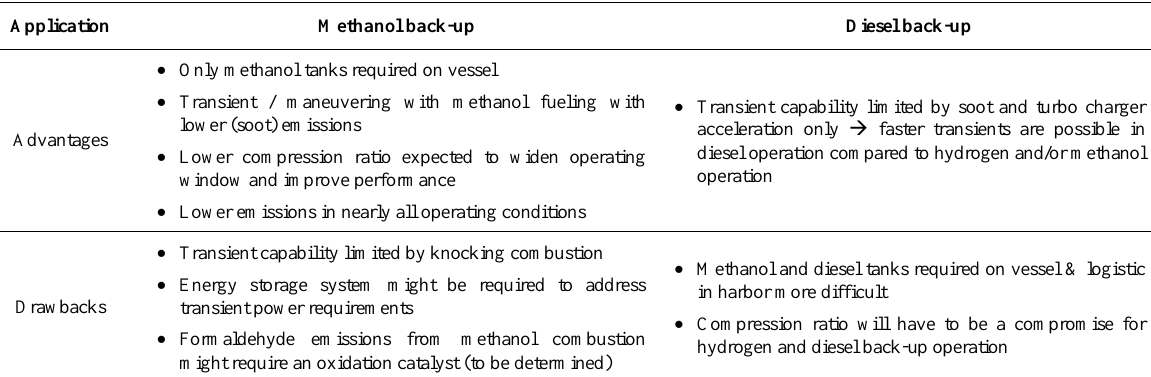
Table 1. Methanol vs. diesel back-up